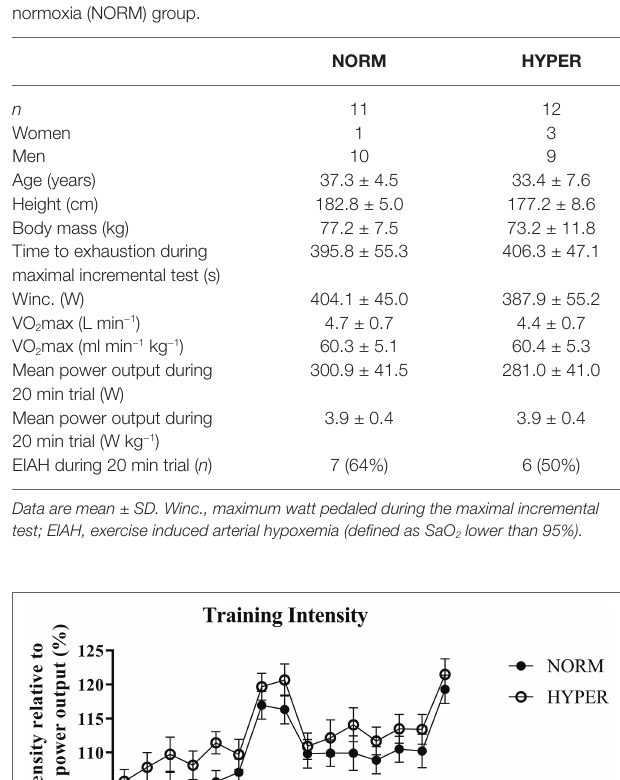
TABLE 1 | Characteristics and baseline measures of the hyperoxia (HYPER) and normoxia (NORM) group.